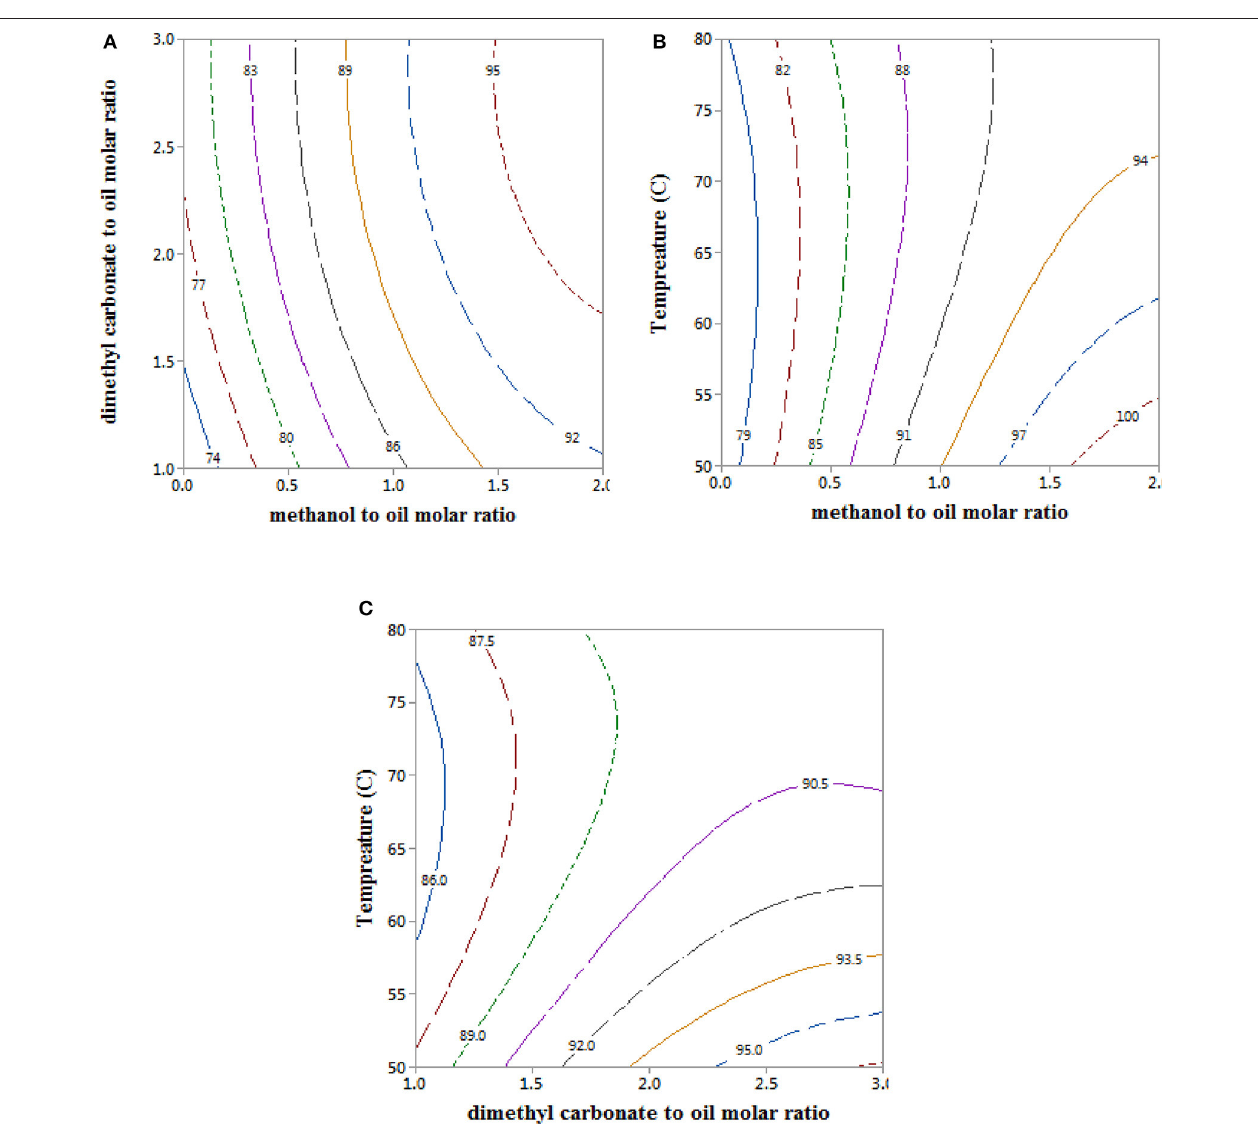
FIGURE 2 | Contour plots for the effect of DMC, methanol, and temperature on the FAME yields for reactive coupling of RSO transesterification with in situ crude glycerol valorisation to GLC. (A) Interaction between DMC and MeOH to RSO molar ratio at 65 ◦ C, (B) interaction between temperature and methanol to RSO molar ratio at 2DMC and (C) interaction between temperature and DMC at 1